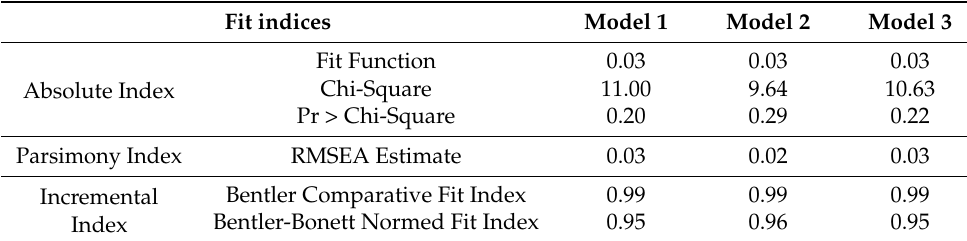
Table 4. Fit indices for models’ gestational age, birthweight and Apgar